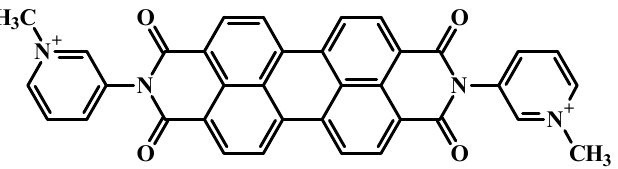
Figure 1. The structural formula of the perylene-3,4:9,10-bis(dicarboximide)-N,N-bis(1-methyl-3pyridinium) bis-n-toluenesulfonate (2416SL) molecule.